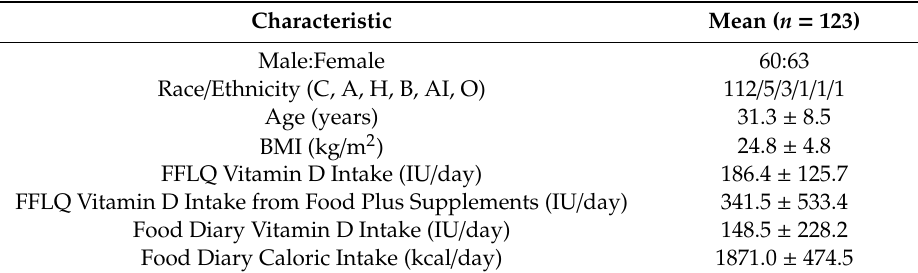
Table 4. Characteristics of Active Participants (Study 2).